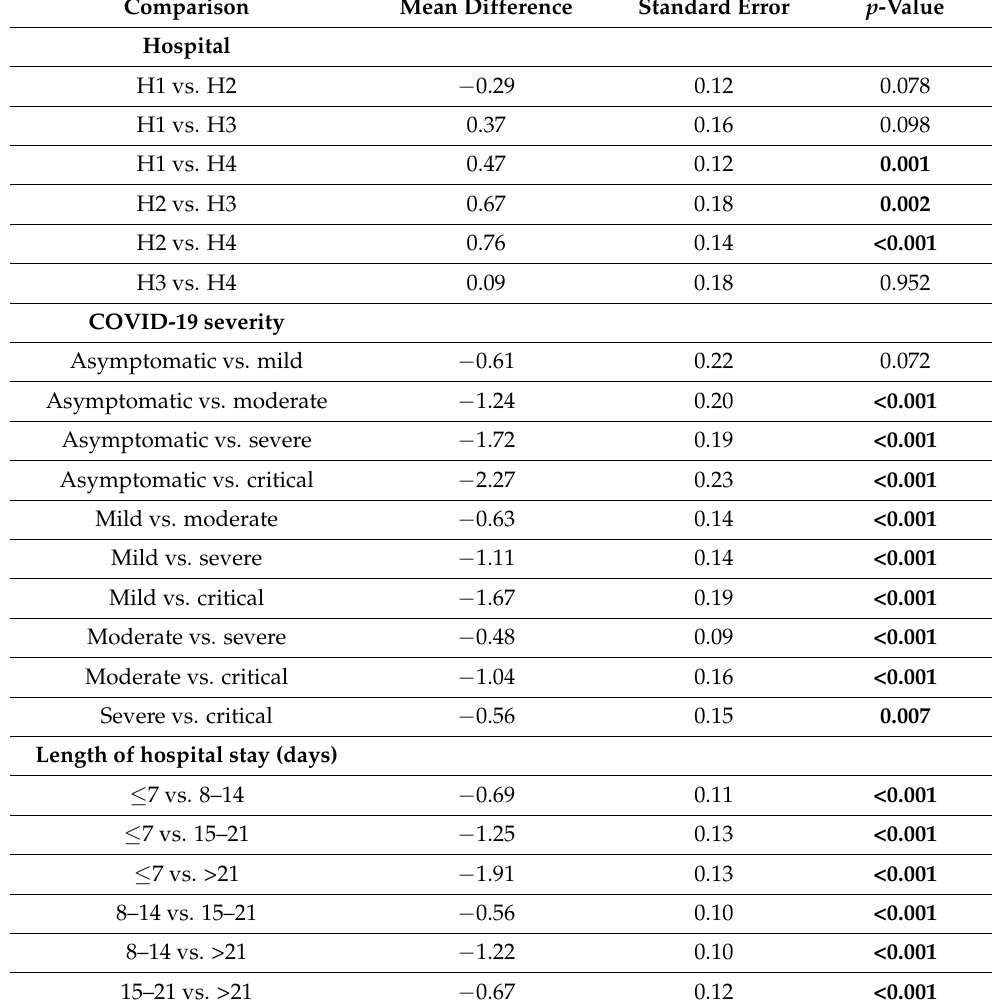
Table 5. Post hoc analysis of antibiotic use among hospital and COVID-19 severity categories.